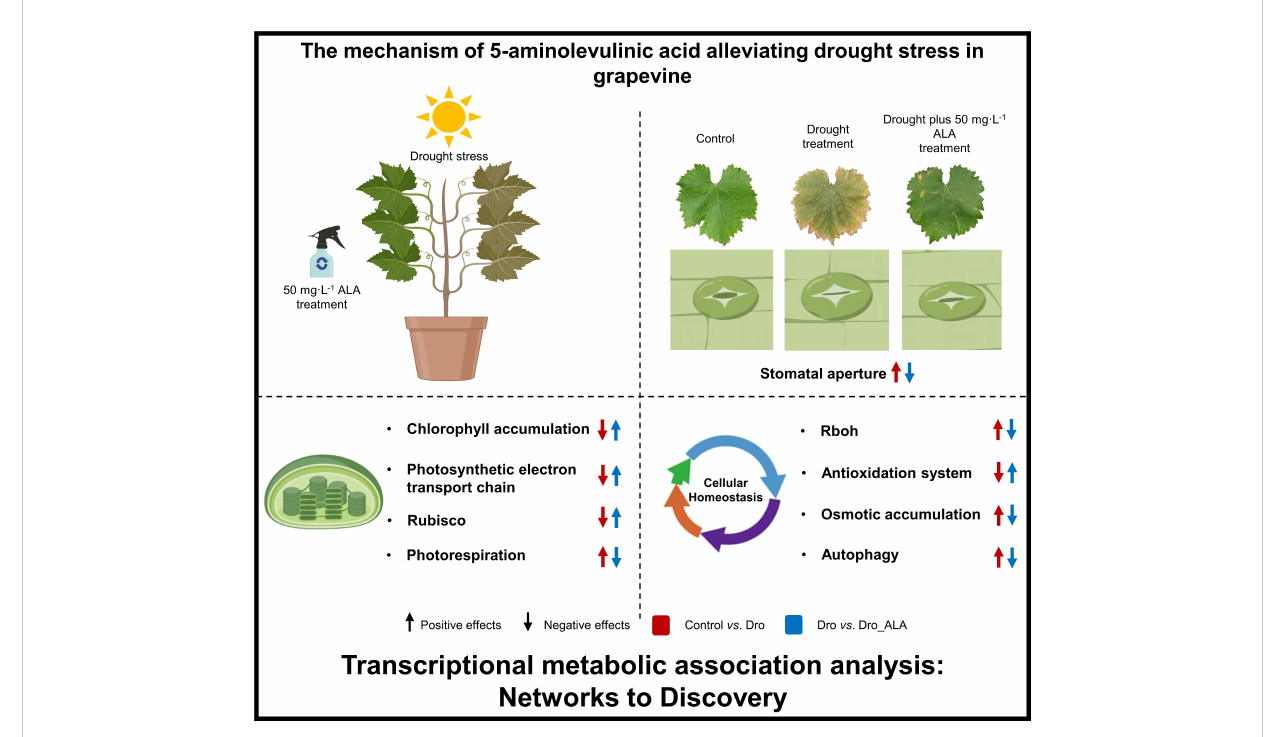
FIGURE 5 Regulation network of 5-aminolevulinic acid to mitigate drought stress in